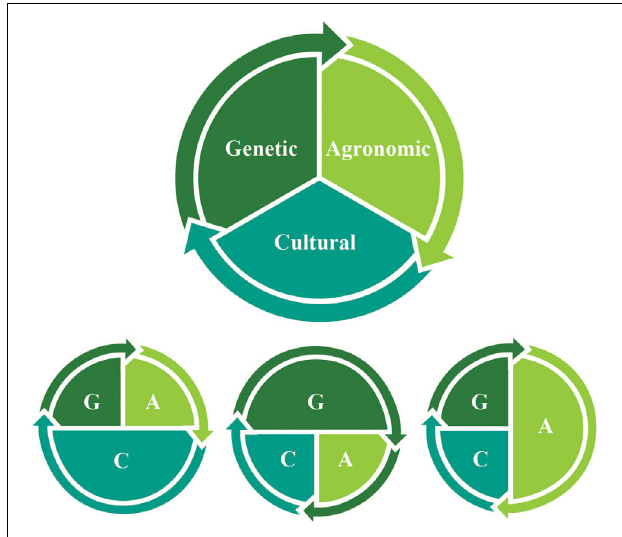
FIGURE 1 | Varying magnitudes of genetic (G), agronomic (A), and cultural (C) change and their interactions drive de novo domestication